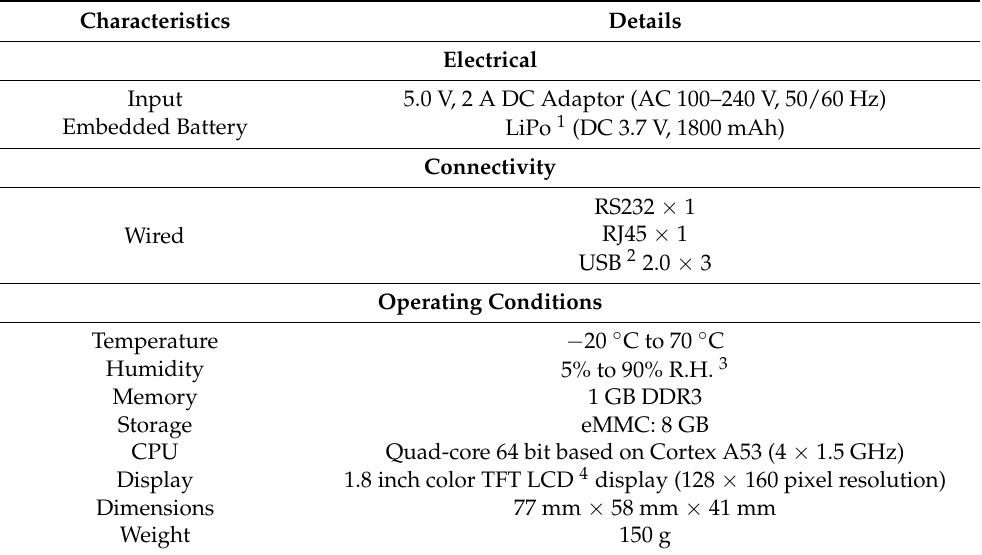
Table A2. Specifications of NEO